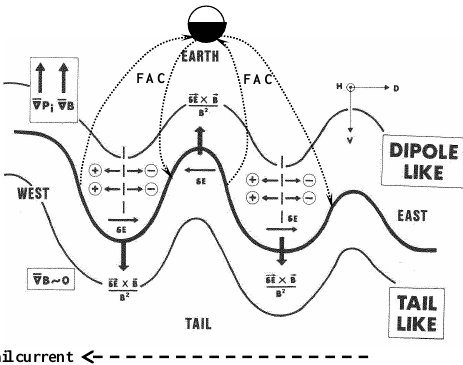
Fig. 12. Sketch of the drift wave instability at the near- Figure 12 Sketch of the drift wave instability at the near-geosynchronous plasma sheet. See the text for geosynchronous plasma sheet. See the text for explanations